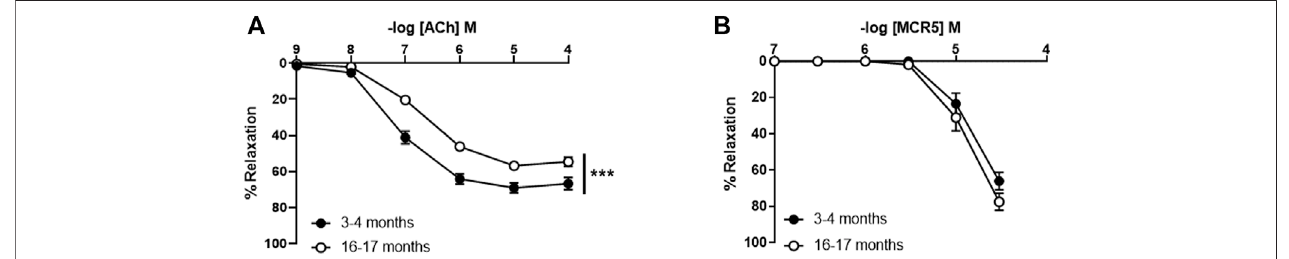
FIGURE 8 | In fl uence of aging on aortic relaxations. Concentration-response curves to acetylcholine (ACh) in U46619-pre-contracted aortic rings from 3- to 4- month-old(young)and16-to17-months-old(old)C57BL/6mice (A) .Concentration-responsecurvestoMCR5 (B) .Resultsaremean±SEMfrom n =13 – 15 (A,B) mice. ppp p < 0.001 by two-way repeated measures ANOVA with Bonferroni ’ s post hoc